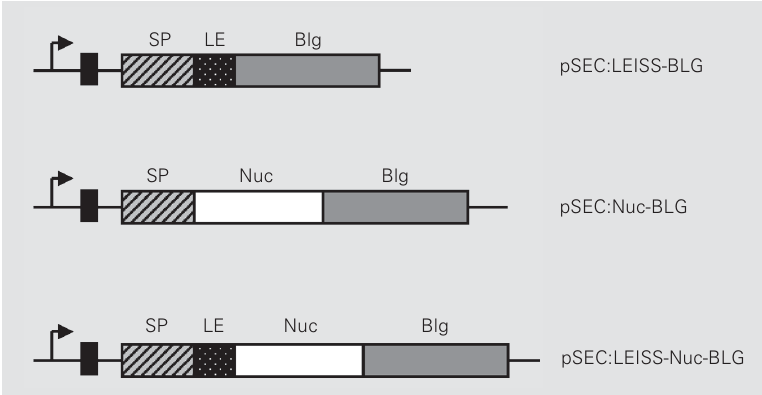
Figure 1. Expression cassettes for bovine ß-lactoglobulin (BLG) production and export in Lactococcus lactis . Schematic structures of BLG and BLG fusions expressed under control of the lactococcal nisin-inducible promoter (P nisA ) and carried by the indicated plasmids are presented. The arrows indicate the L. lactis promoter sequence of P nisA ; the solid vertical bars indicate the ribosome binding sites of the usp45 gene (Ref. 16); the striped bars indicate the signal peptide of the usp45 gene (SP); the dotted bars indicate the DNA fragment encoding the LEISSTCDA (LEISS) propeptide (LE); the shaded bars indicate the region encoding BLG (Blg); the open bars indicate the sequence encoding the staphylococ- cal nuclease (Nuc; not to